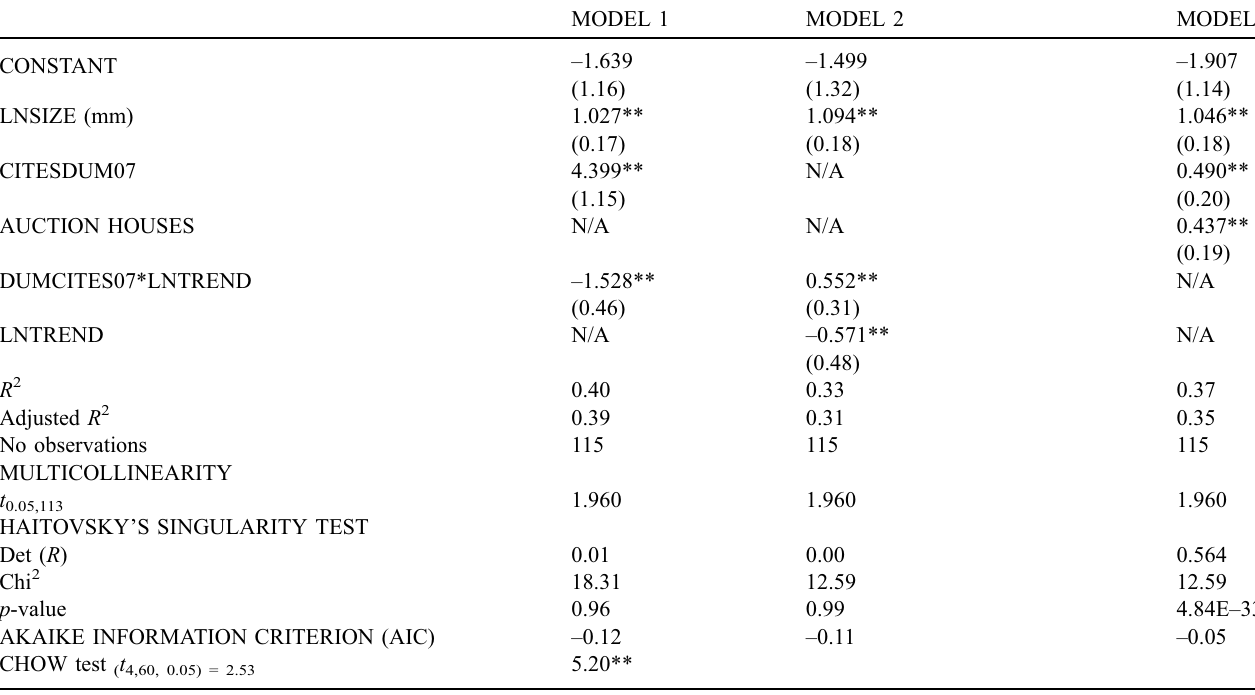
Table 1. Estimated values for three tested